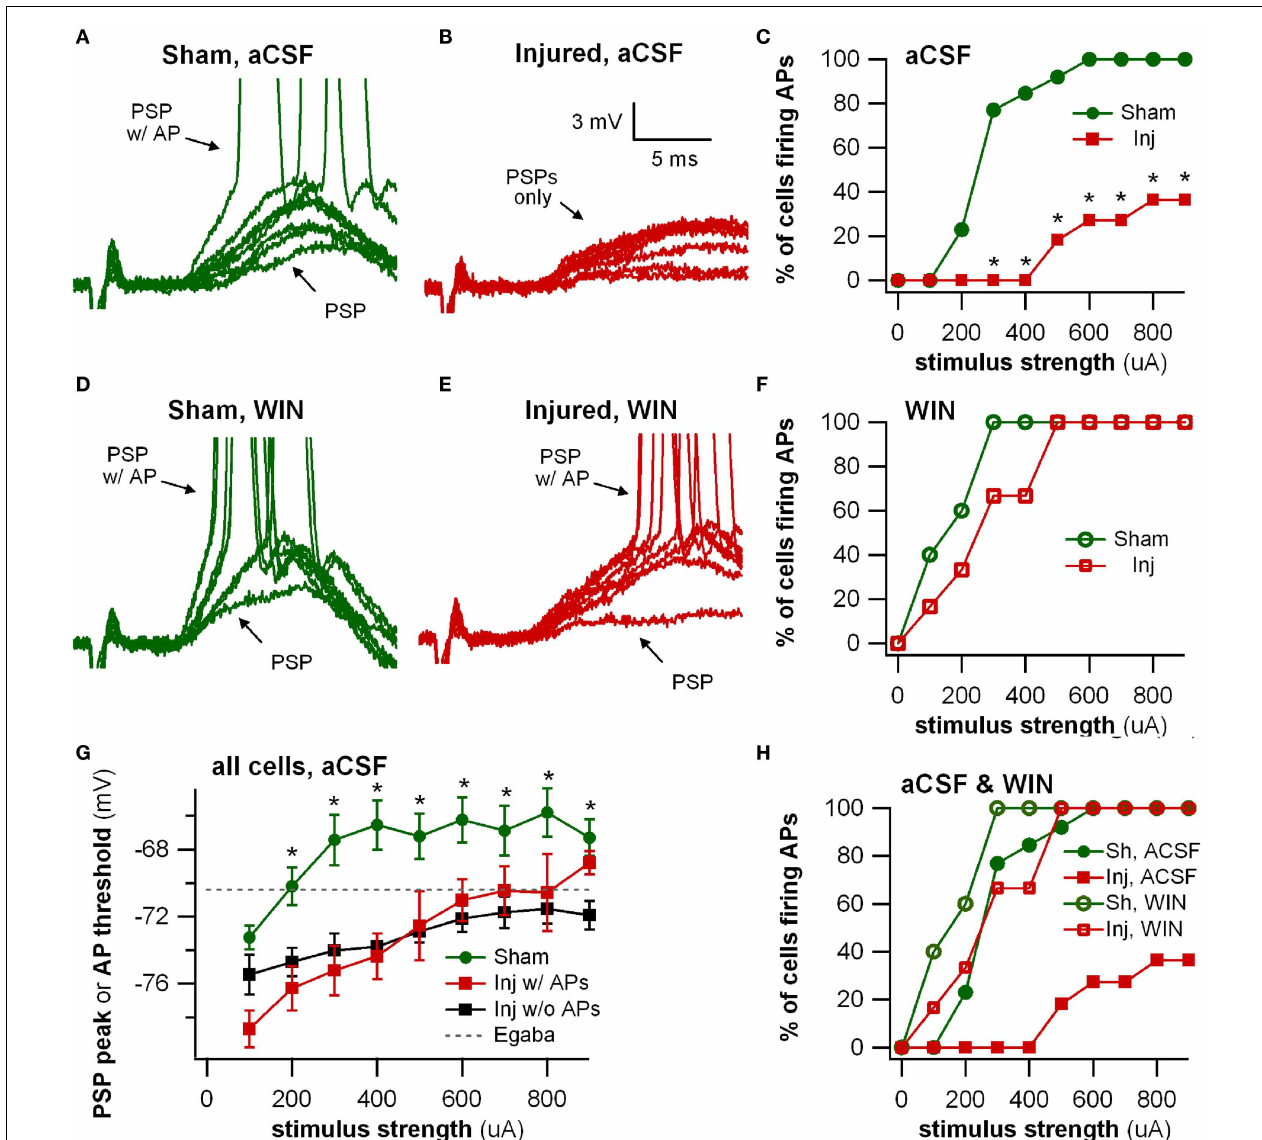
FIGURE 8 | Stimulus-evoked action potentials (APs) are reduced after injury, and restored to normal when GABAergic signaling by CCK positive interneurons is suppressed .Whole-cell current clamp recordings from individual CA1 pyramidal neurons in response to SR stimulation in aCSF and in solution containing the cannabinoid agonistWIN55,212-2. (A) Representative whole-cell current clamp recording in aCSF in